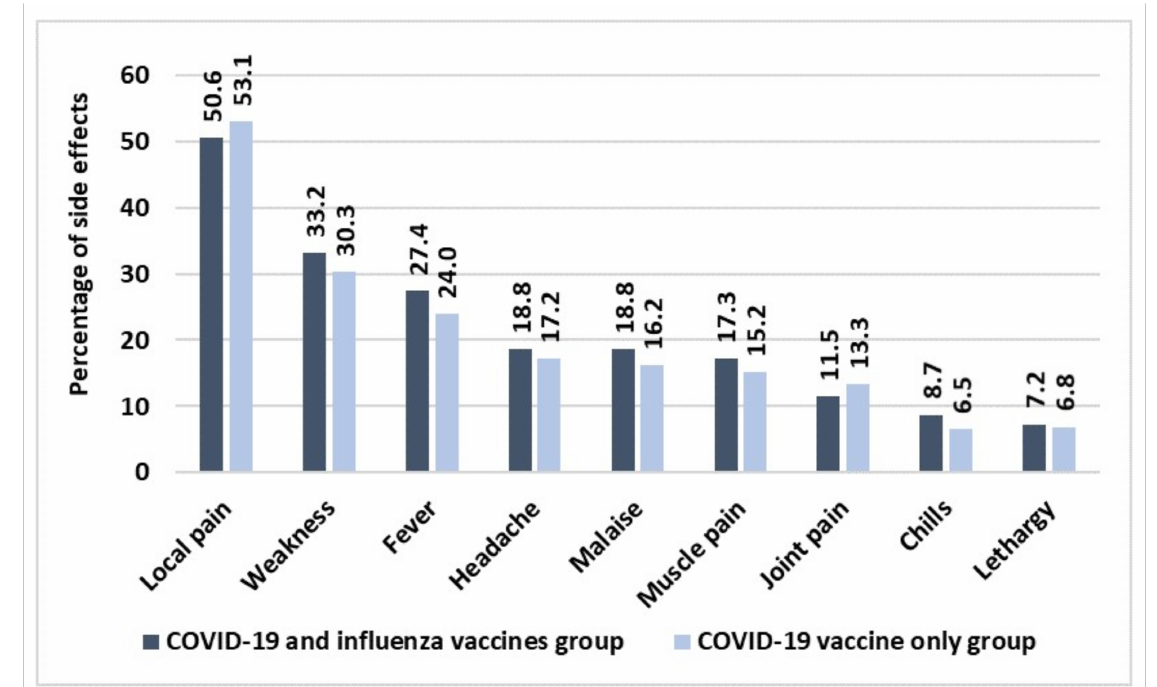
Figure 3. Comparison in the onset of side effects between both the two study groups. Size sample of both the two groups: 64